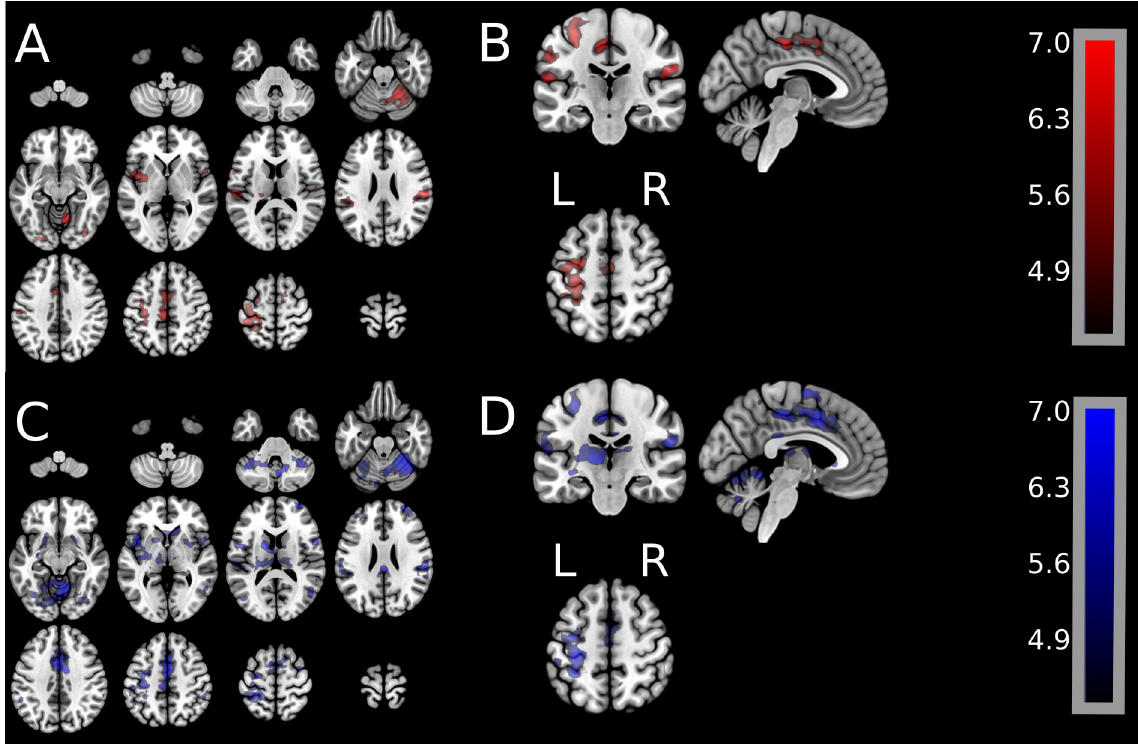
Fig 2. Group-level GLM activation maps for the wrist extension movement and for the wrist flexion movement. Panels A/B show spatial brain activation for wrist extension (extension movement–rest). Panels C/D show spatial brain activation for wrist flexion (flexion movement– rest). Images were assessed for cluster-wise significance using a forming threshold of p < 0.001 uncorrected (p < 0.05 FWE-corrected). Critical cluster sizes were 702 mm 3 and 945 mm 3 for wrist extension and wrist flexion, respectively. Color bar for the t-statistics shows the gradient from the lowest to the highest